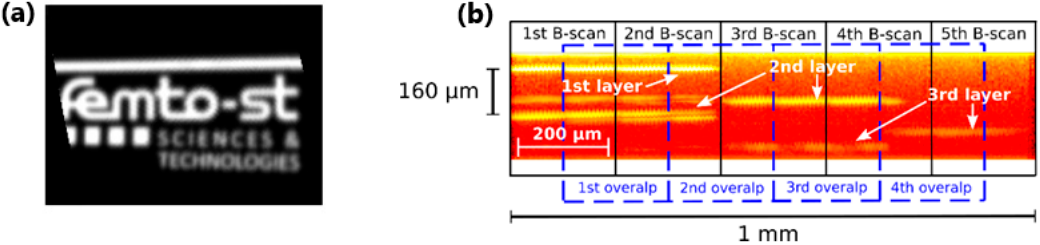
Figure 22. Reconstruction of a “femto-st” pattern in ( a ) and B-scan of a multilayer glass sample in ( b